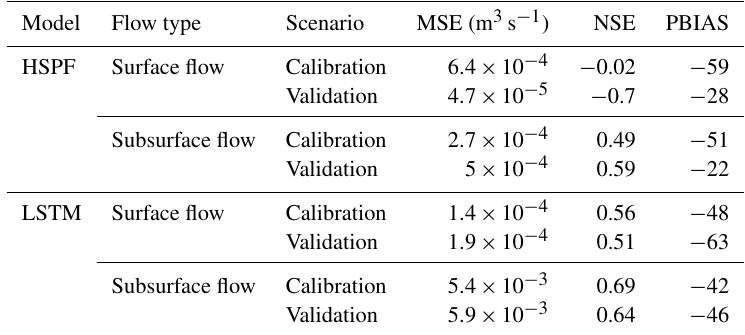
Table 3. Performance metrics of HSPF and the LSTM model for surface and subsurface flow.